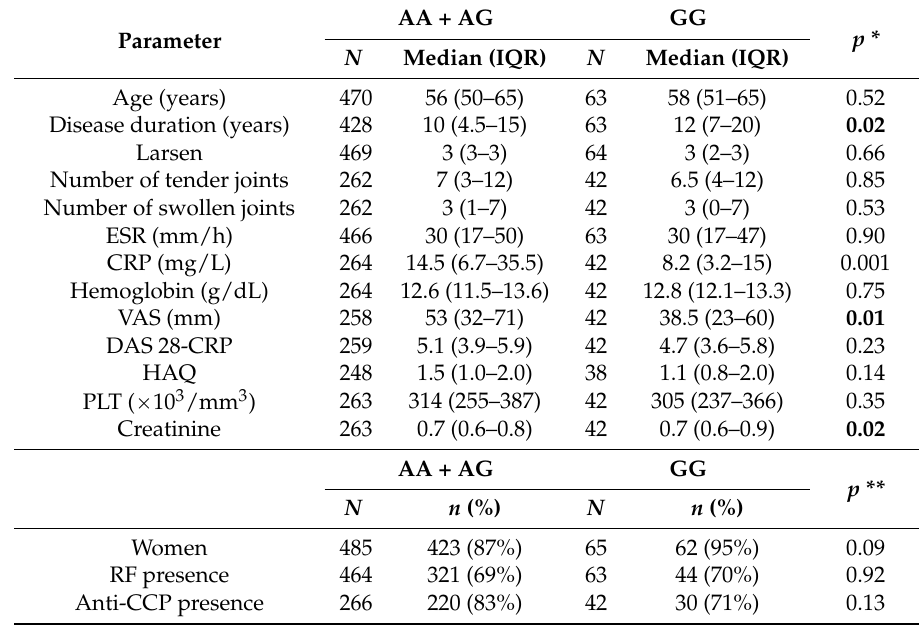
The disease activity and laboratory parameters in relations to RORc2 rs9826 A/G; recessive